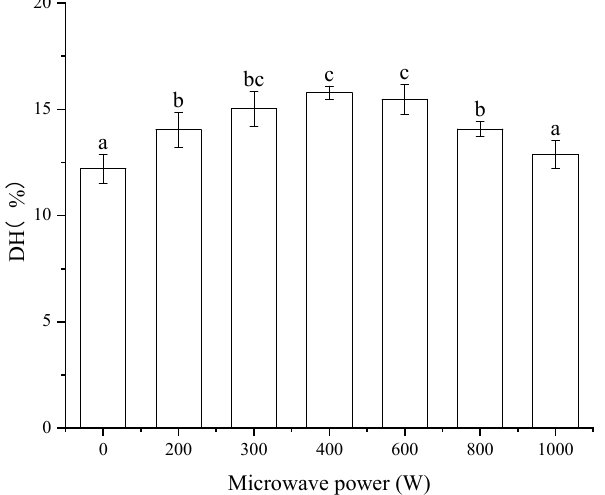
Figure 1. The effects of microwave pretreatment on the DH of MP. Results represent the means of three determinations ± standard deviation. Means with different superscripts (a, b, c) are significantly different ( p < 0.05).